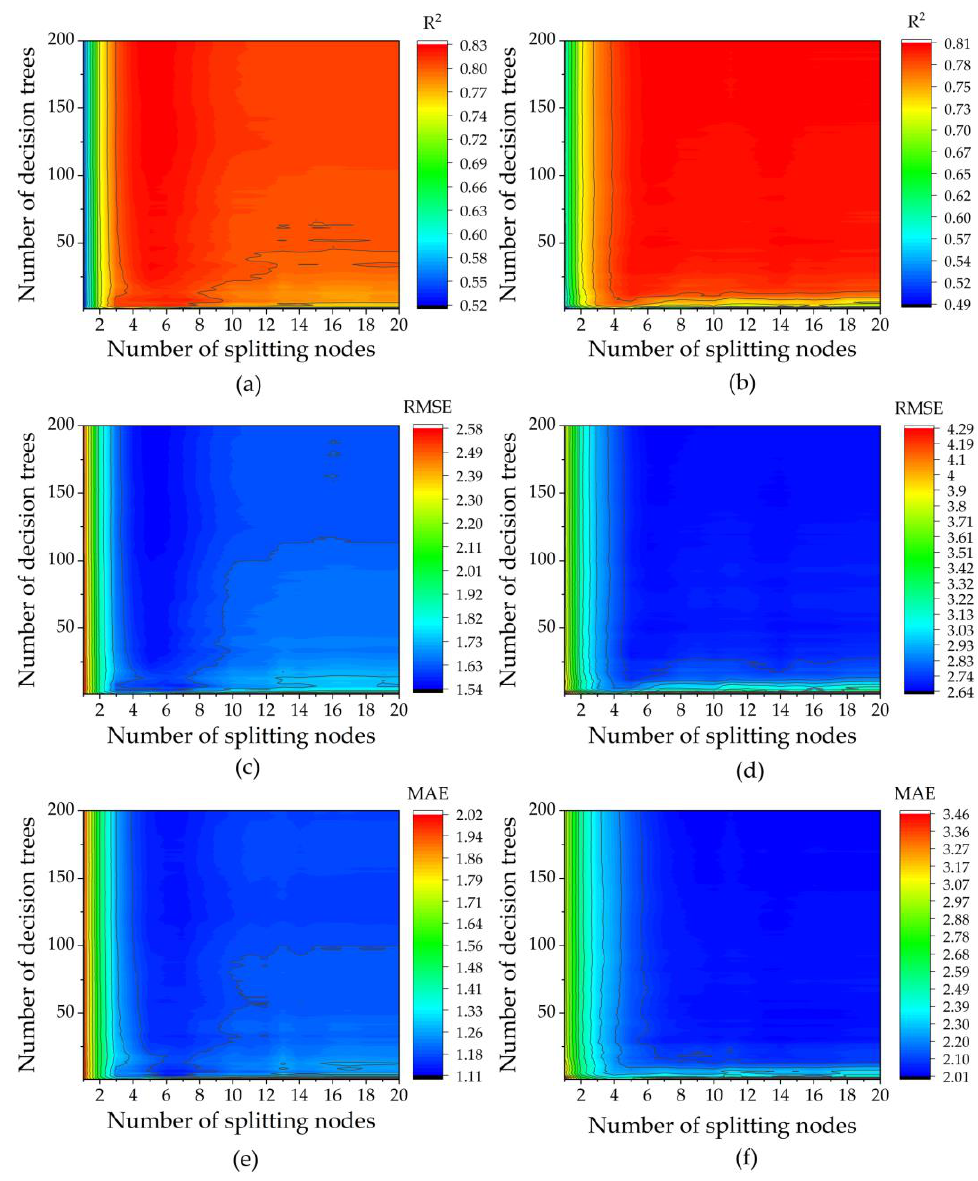
Figure 7. The performance of the RF model with variable numbers of decision trees and splitting nodes: ( a , c , e ): T wet ; ( b , d , f ): T dry